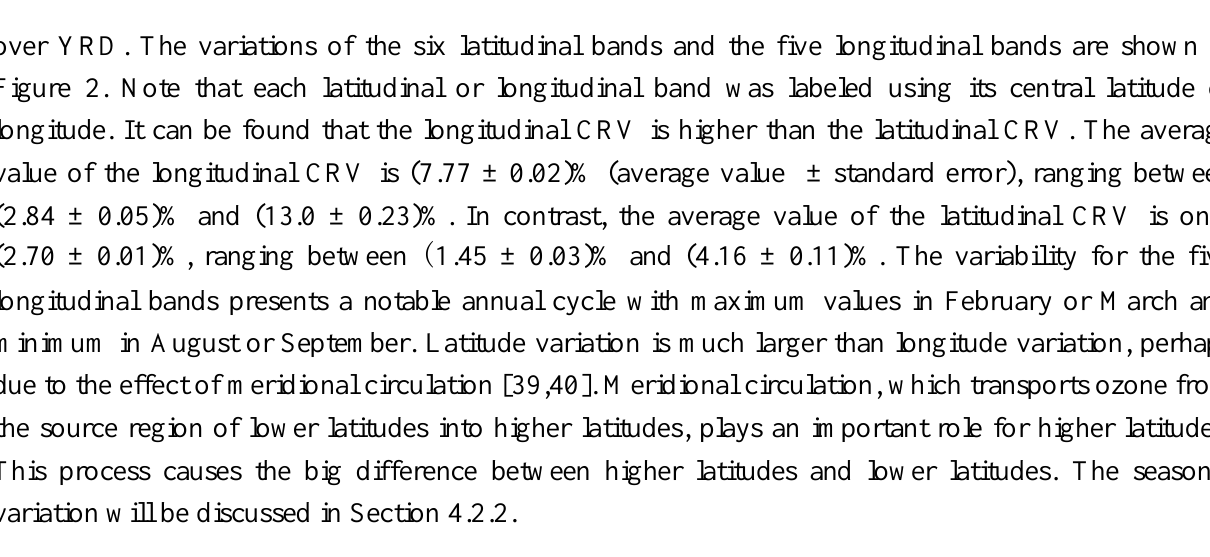
Figure 2. Monthly mean evolution of the coefficient of relative variation (CRV) for ( a ) six latitudinal bands and ( b ) five longitudinal bands in the Yangtze River